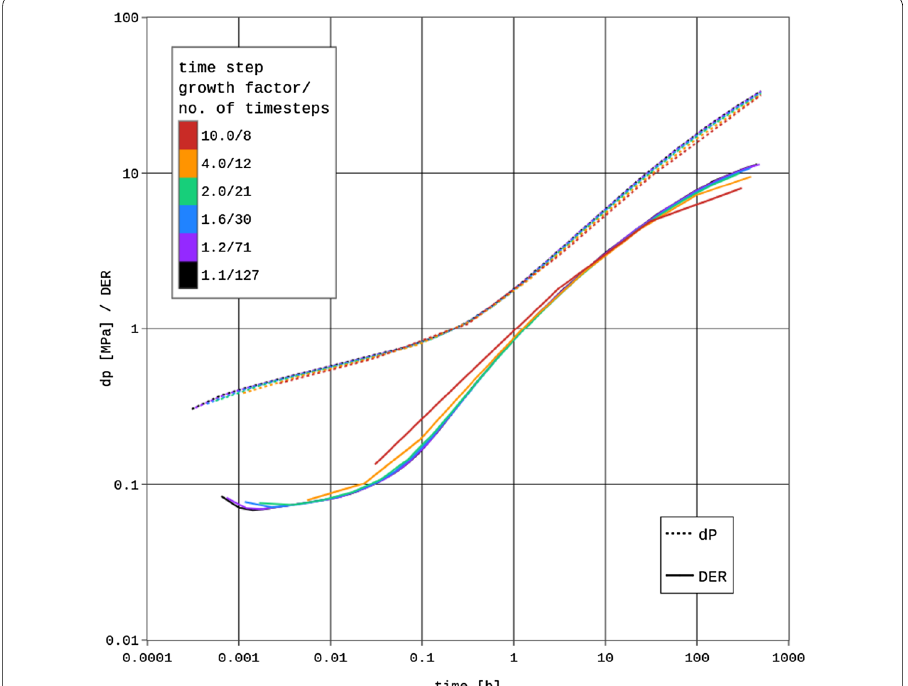
Fig. 5 Influence of temporal discretization on simulation result; initial time step